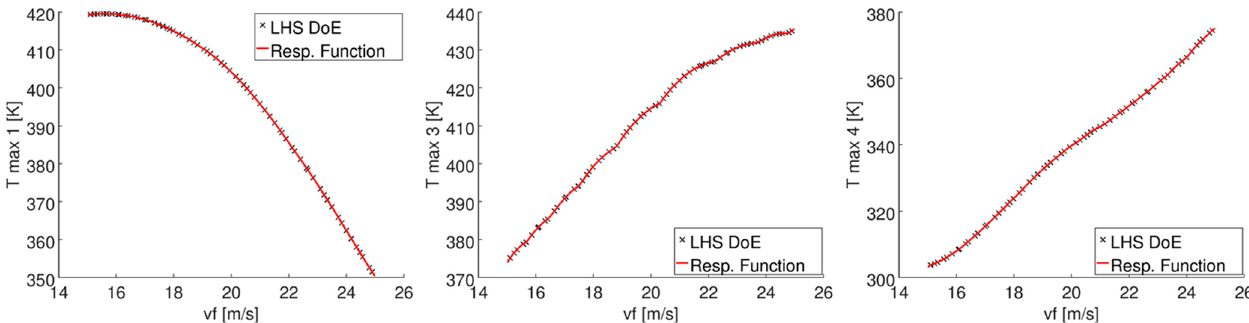
Figure 10. Maximum temperatures from DoE.